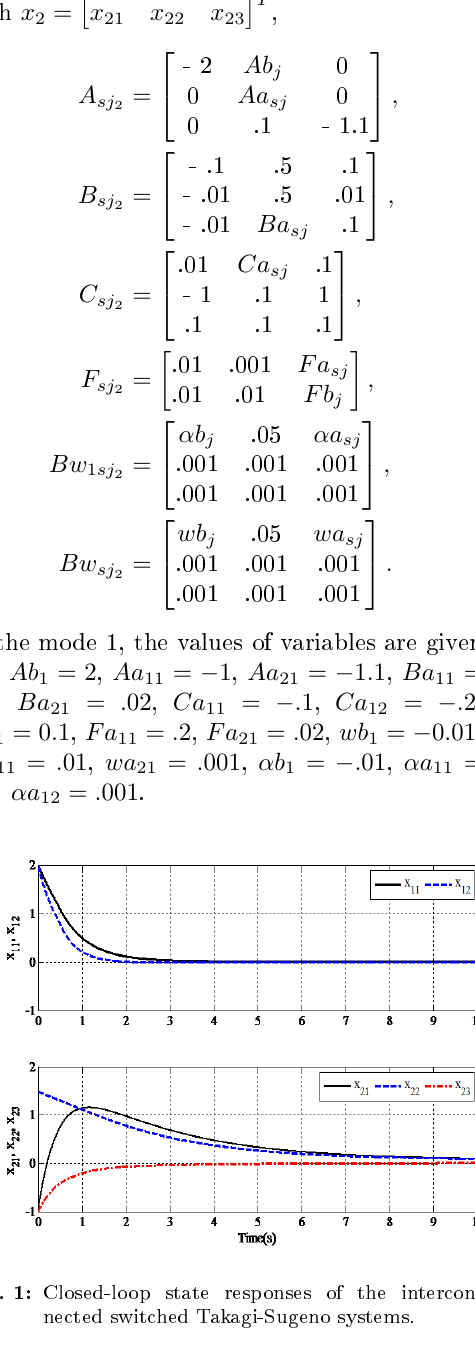
In the mode 2, the values of variables are given by: Ab 2 = 1 , Aa 12 = − 2 , Aa 22 = − 3 , Ba 12 = 0 . 03 , Ba 22 = 0 . 04 , Ca 21 = − . 4 , Ca 22 = − . 3 , Fb 2 = 0 . 2 , Fa 21 = Fa 22 = . 4 , wb 2 = 0 . 01 , wa 12 = . 02 , wa 22 = . 05 , αb 2 = . 01 , αa 21 =